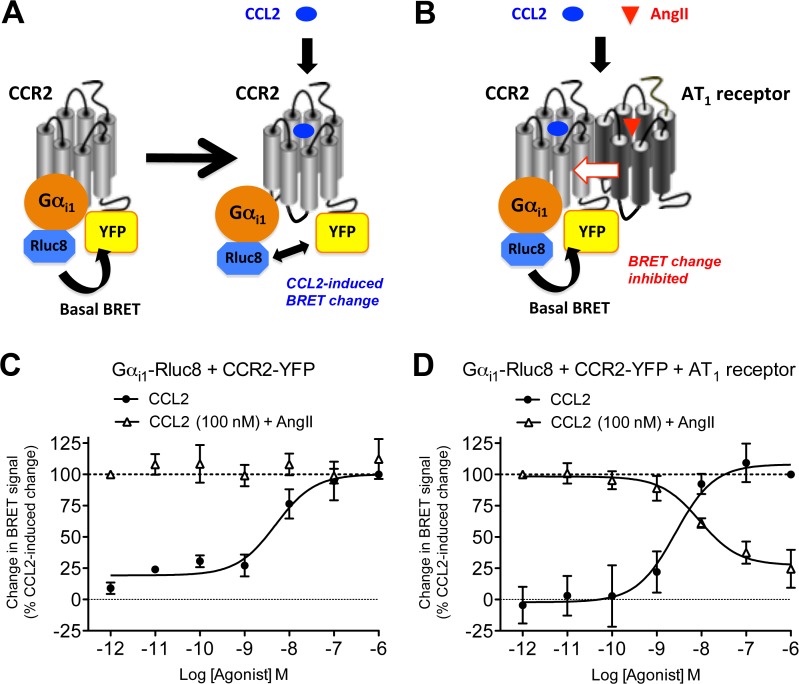
Use of GPCR-HIT to show effect of AT1 receptor activation on CCR2/Gαi1 proximity.Live HEK293FT cells co-expressing Gαi1-Rluc8 with either CCR2-YFP only (A and C) or CCR2-YFP and AT1 receptor (B and D) were used to measure the change in BRET signal with increasing doses of CCL2, or 100 nM CCL2 with increasing doses of AngII (C and D). It has been observed previously [39,41,42,44] that the BRET signal can increase or decrease as a consequence of the ligand-induced conformational change associated with Gαi1 protein activation (A). The data are presented here as change in BRET signal as a percentage of CCL2-induced change for ease of interpretation. 100% is defined in each individual experiment as the decrease in BRET signal observed upon addition of 1 μM CCL2 (for curves with black circles), or 100 nM CCL2 + 1 pM AngII (for curves with white triangles). Data are presented as mean ± SEM of three (C) or five (D) independent experiments. CCL2 logEC50 in (C) = -8.27 ± 0.20 and in (D) = -8.67 ± 0.13 (not significantly different (unpaired t-test, P > 0.05)). In the presence of AT1 receptor, logIC50 for AngII inhibiting 100 nM CCL2 = -8.19 ± 0.31.